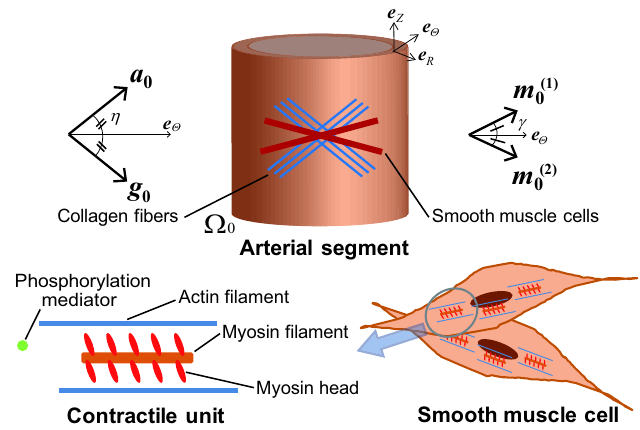
Fig. 1 Schematic of arterial components: An artery comprises a noncollagenous matrix, two families of fibers, and two families of smooth muscle cells. The reference directions of the two families of fibers and two families of smooth muscle cells are represented by the unit vectors a 0 and g m (1) and m (2) , respectively. A smooth muscle cell contains many contractile units. A basic contractile 0 0 unit comprises two actin filaments and one myosin filament connected by many myosin heads. The set { e , e Θ , e } is the local covariant basis of the cylindrical coordinate R Z